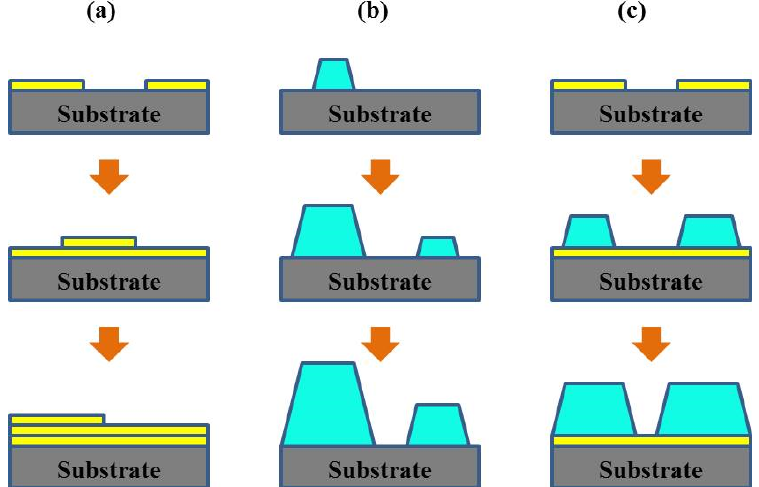
Figure 2. Spherical cap-shaped nucleus on surface: θ refers to the wetting angle (contact angle); α refers to surface tension of spherical cap-shaped nucleus; α 1 refers to surface tension of surface; α 2 refers to α 1 refers to interfacial tension between nucleus and